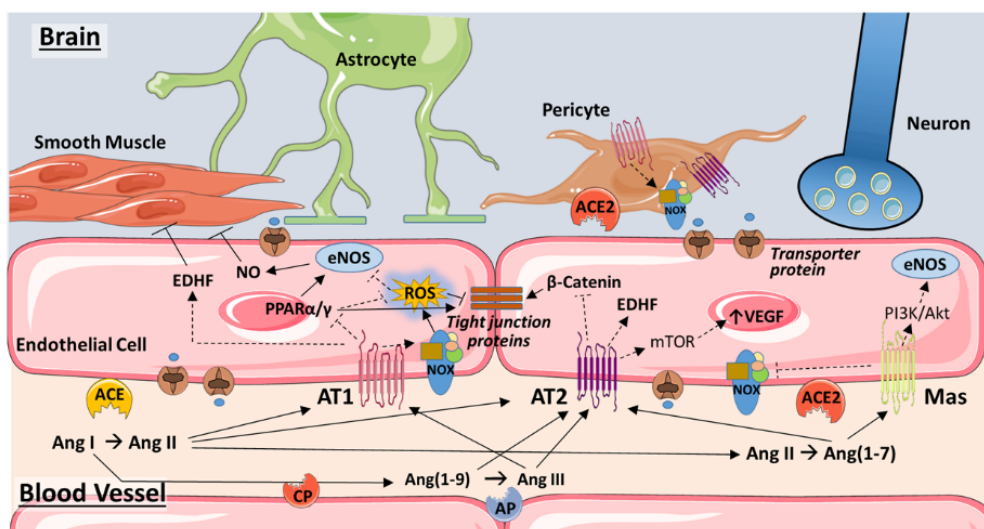
Figure 2. Angiotensin signaling in the endothelium of the blood–brain barrier. Traditional and novel components of the renin–angiotensin system (RAS) converge at the level of the endothelium to modulate blood flow, vascular remodeling, and brain permeability. Ang II formed by the actions of ACE on Ang I may act on the AT1 receptor to induce either vasodilation, via production of EDHF, or vasoconstriction by stimulating ROS production via Nox2 and attenuating eNOS-induced NO production. Inhibition of PPARα/γ may exacerbate ROS production. Ang II-induced ROS and inhibition of PPARα/γ may act synergistically to increase blood–brain barrier permeability by impeding the expression or functioning of tight junction proteins. ROS contributes as well to adverse vascular remodeling and vessel rarefaction that impedes blood flow and occurs with hypertension and aging. Through AT2R, Ang II may induce vasodilation via EDHF production. AT2R is also linked to cardioprotective effects via vascular endothelial growth factor (VEGF) expression, as well as strengthening of interendothelial junctions via inhibition of β-catenin. However, VEGF is also implicated in the disruption of the blood–brain barrier. NO may also increase AT2R expression, which in turn may reduce ACE levels (not shown). Ang(1–9), Ang(1–7), and Ang III may activate AT2R as well, with Ang III also acting on AT1R. Ang(1–7), formed from Ang II by ACE2, acts upon the Mas receptor to constitute a protective arm of RAS through inhibition of Nox2 and activation of eNOS. In pericytes, AT1R activation may induce oxidative stress by increasing Nox4, thereby triggering pericyte loss and compromising the blood–brain barrier. Based on recent research in the heart, brain pericytes may also express ACE2. Not shown are the RAS components associated with astrocytes and neurons. See text for additional details. Abbreviations: ACE, angiotensin converting enzyme; AP, aminopeptidase; AT1, angiotensin II type 1 receptor; AT2, angiotensin II type 2 receptor; CP, carboxypeptidase; EDHF, endothelium-derived hyperpolarizing factor; eNOS, endothelial nitric oxide synthase; mTOR, mammalian target of rapamycin; NO, nitric oxide; NOX, NADPH oxidase; PI3K, phosphoinositide 3-kinase; PPARα/γ, peroxisome proliferator-activated receptor alpha/gamma; ROS, reactive oxygen species; VEGF, vascular endothelial growth factor. Some images are from Servier Medical Art (https://smart.servier.com/).